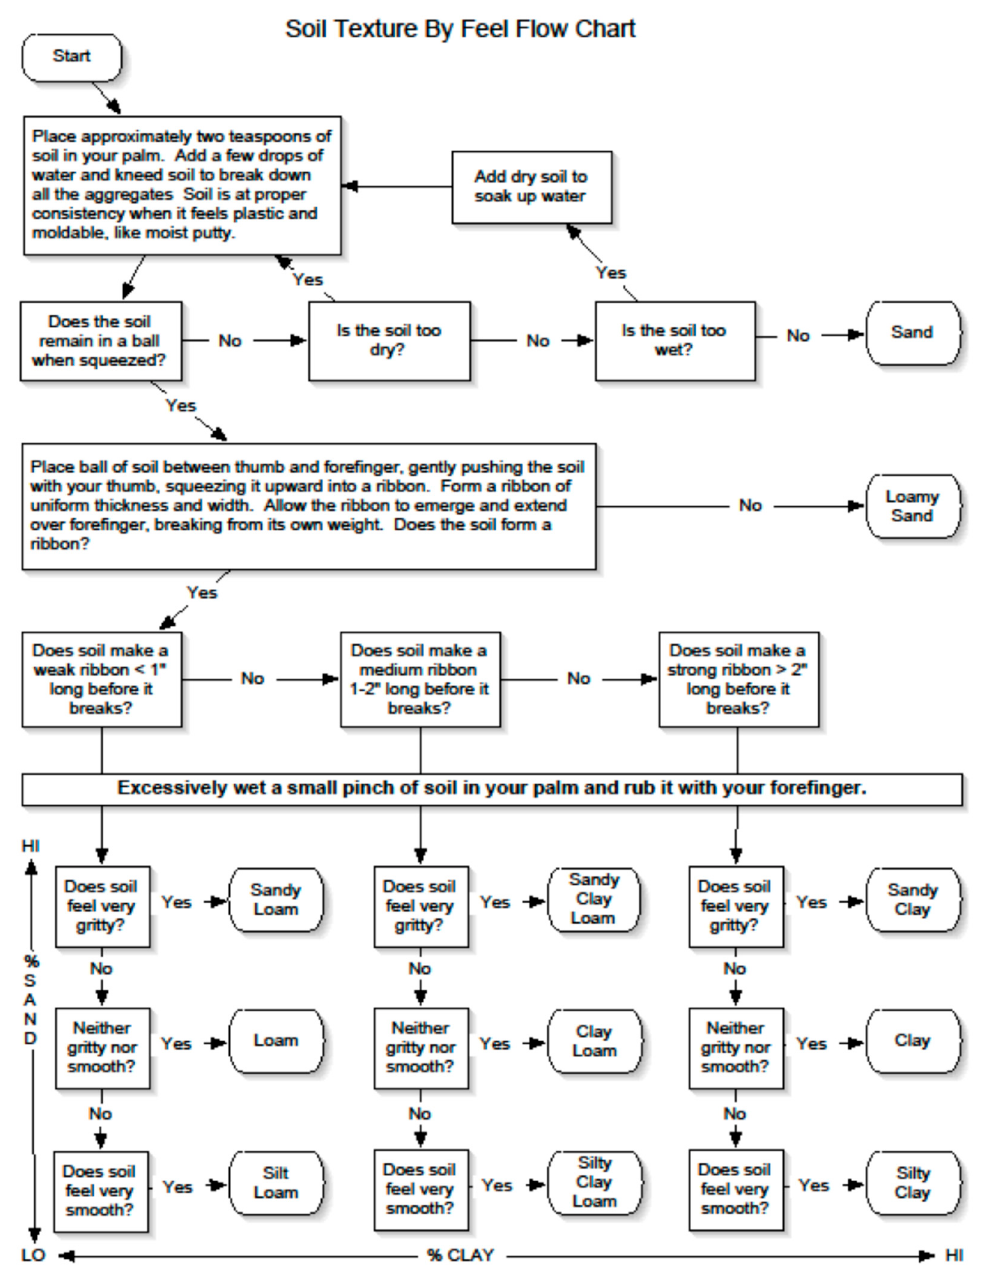
Figure A1. Flow chart and textural triangle used as a guide in the field to determine soil texture by feel which was used to determine field capacity of soil in the rooting zone.